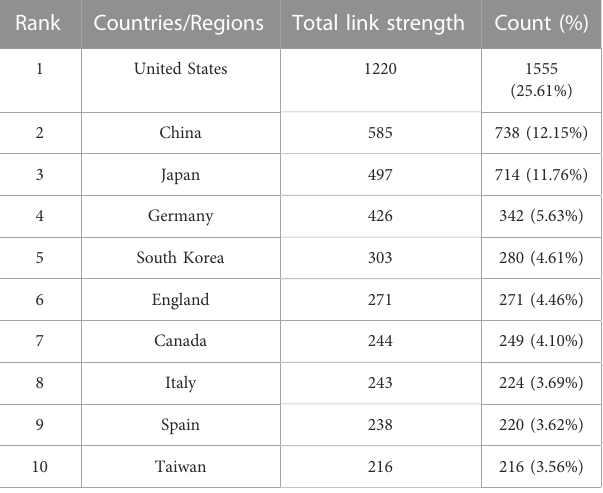
TABLE 1 Top 10 countries/regions with highest publications on stem cells in stroke.